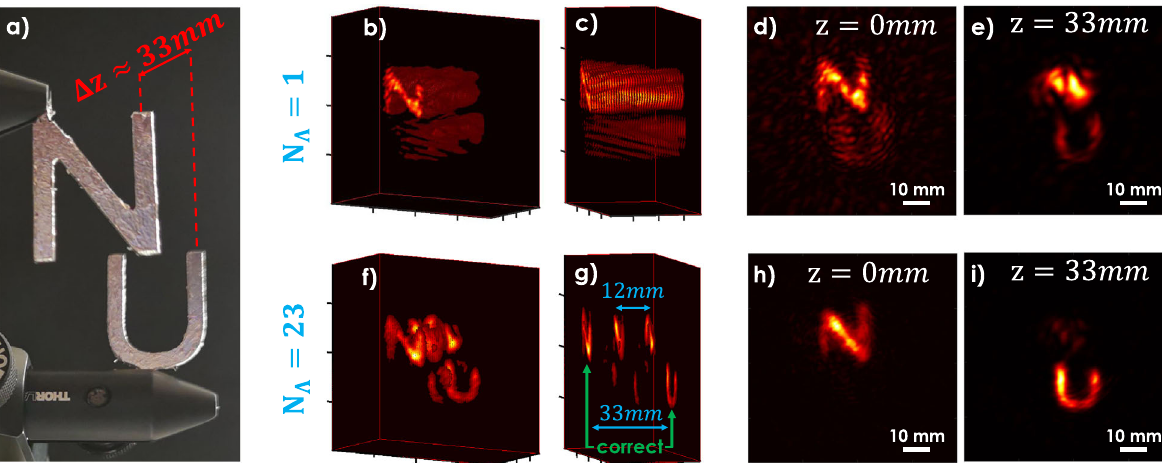
Fig. 4 Experimental demonstration of synthetic pulse holography: generation of a ’ synthetic pulse train ’ using SWH. a Target, consisting of two characters with a longitudinal separation of 33 mm. b – e Reconstruction of the characters, using only N Λ = 1 SWL ( Λ = 0.8 mm). Due to the properties of holographic backpropagation, a separation of the characters for different depths z is not possible. f – i Reconstructions obtained from the coherent superposition of the backpropagated fi elds at N Λ = 23 SWLs. Letters are separable. The pulse distance of the synthesized pulse train can be seen in f and g .